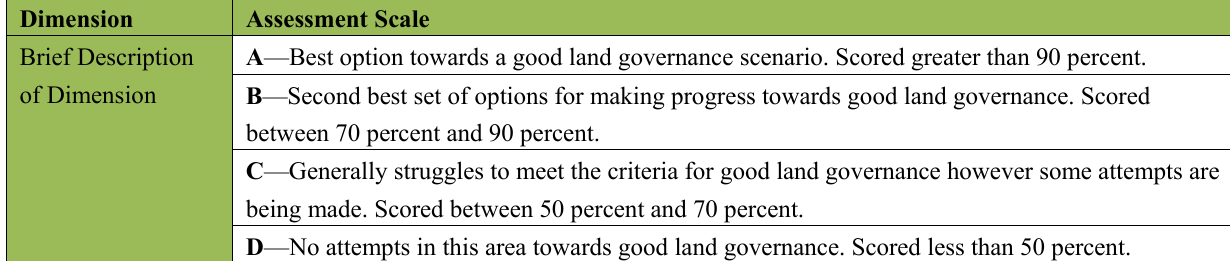
Table 3. Scores of land governance based on global experiences. Source: Bugri